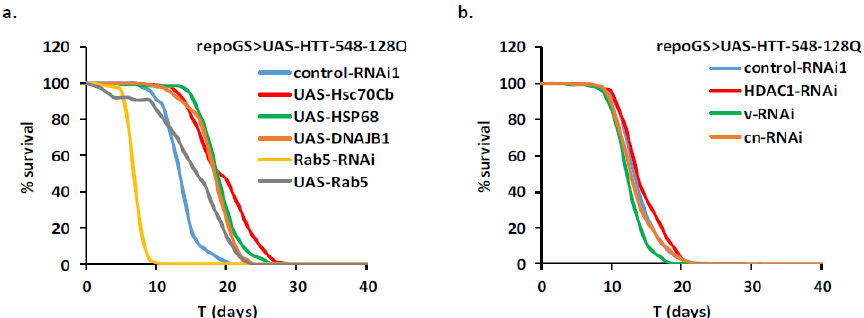
Figure 2. Analysis of known neuronal HD modifiers in glial cells. A repoGS > UAS-HTT-548-128Q line was crossed with transgenic lines allowing modulation of expression of known neuronal HD modifiers. The adult progeny (see Table S4 for detailed genotypes) was transferred at emergence on fly food containing RU486 (100 µ g/mL) to induce the transgenes in glial cells and scored for their lifespan. ( a ) Overexpression of chaperones Hsc70Cb (UAS-Hsc70Cb), HSP68 (UAS-HSP68), the DNAJ1 co-chaperone (UAS-DNAJB1) and of Rab5 (UAS-Rab5) are protective against mHTT induced glial pathology as compared to control (MLS = 18.7, 18.3, 17.5, 14.5; pLogRank < 10 −10 , 10 −10 , 10 −10 , 10 −6 ; n = 154, 148, 164, 76, respectively). In contrast, RNAi mediated depletion of Rab5 (Rab5-RNAi) is strongly deleterious (MLS = 6.3; pLogRank < 10 −10 ; n = 60). Control-RNAi1 flies: MLS = 12.9, n = 122. ( b ) RNAi mediated depletion of HDAC1 (HDAC1-RNAi), cinnabar/KMO ( cn /cn-RNAi) and vermilion/TDO ( v /v-RNAi) have no significant effect or a slightly deleteriou-s effect on lifespan of glial HD flies (MLS = 13.2, 13.8, 11.9, 12.8; pLogRank > 10 −2 , 10 −2 , <10 −4 ; n = 140, 142, 201, respectively). Control-RNAi1 flies: MLS = 13.2, n = 147.